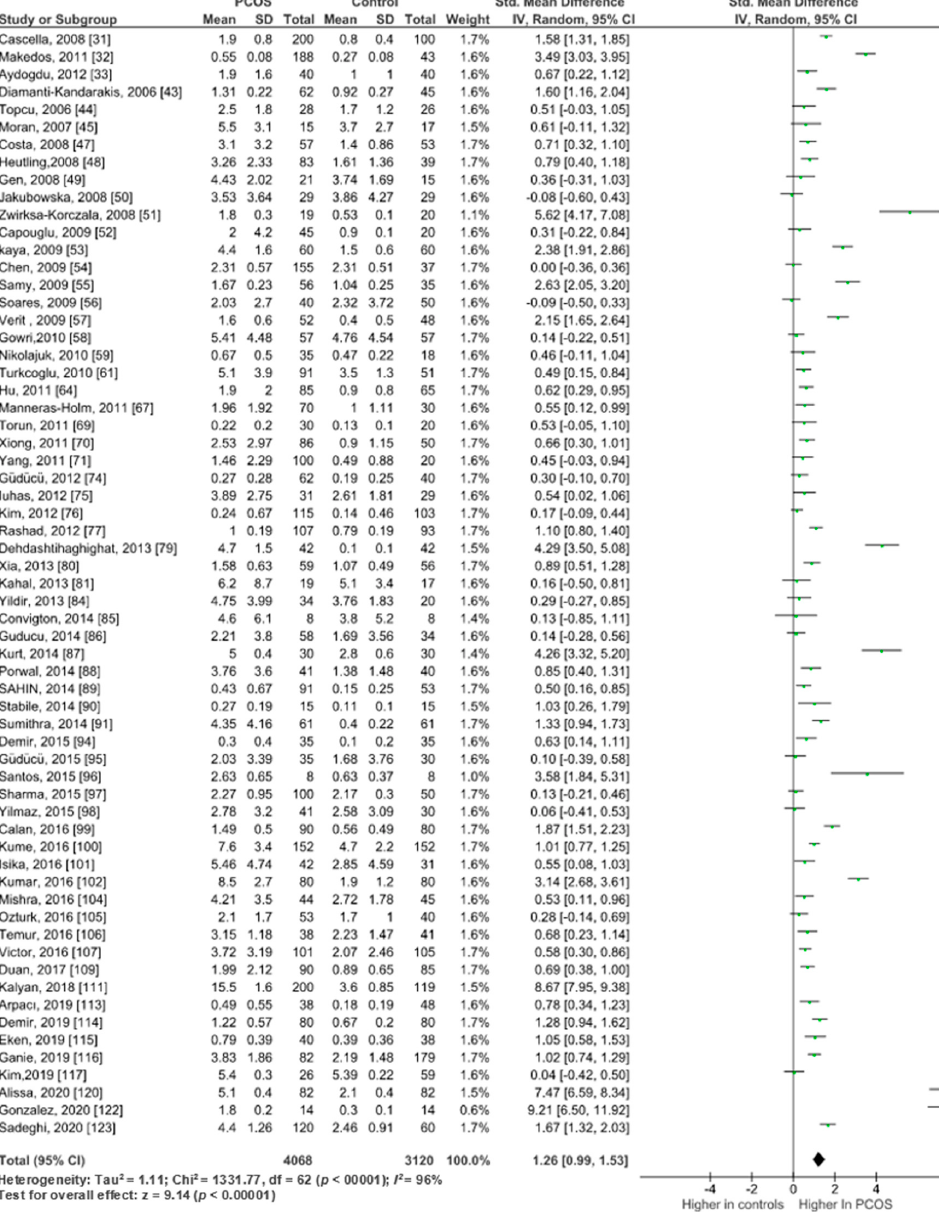
Figure 2. Overall CRP pooled analysis of 63 studies. Studies Using mg/L as a Unit of CRP